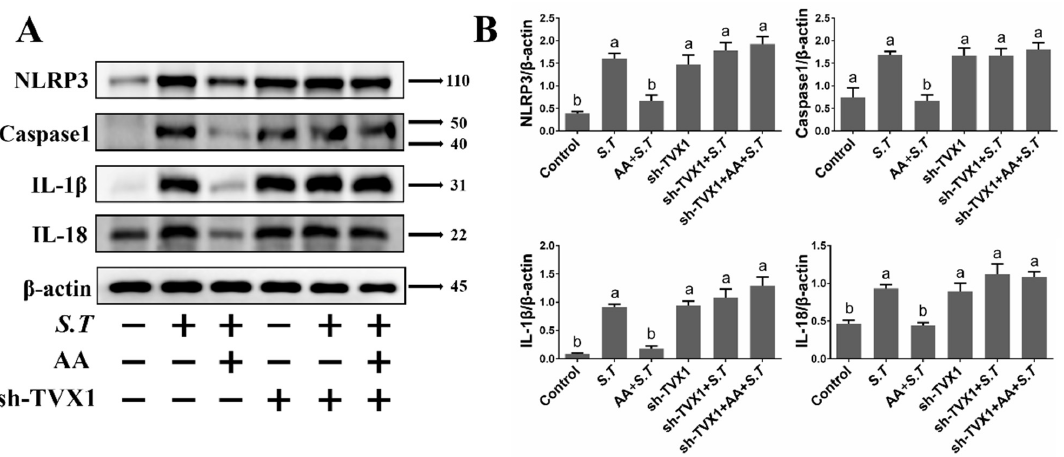
Figure 7. Effect of PCD316-TVX1 on AA Activation of the NLRP3 Inflammasome in S.T -Infected Microglia. Western blotting detection of NLRP3 inflammasome protein changes in microglia. ( A ) Microglia were transfected with PCD316-TVX1 plasmid. Twenty-four hours later, cells were pre- treated with AA for one hour, then infected with S.T , and proteins extracted for analysis. ( B ) NLRP3 inflammasome protein grayscale images (Different letters represent significant differences, p < 0.05, n = 3).